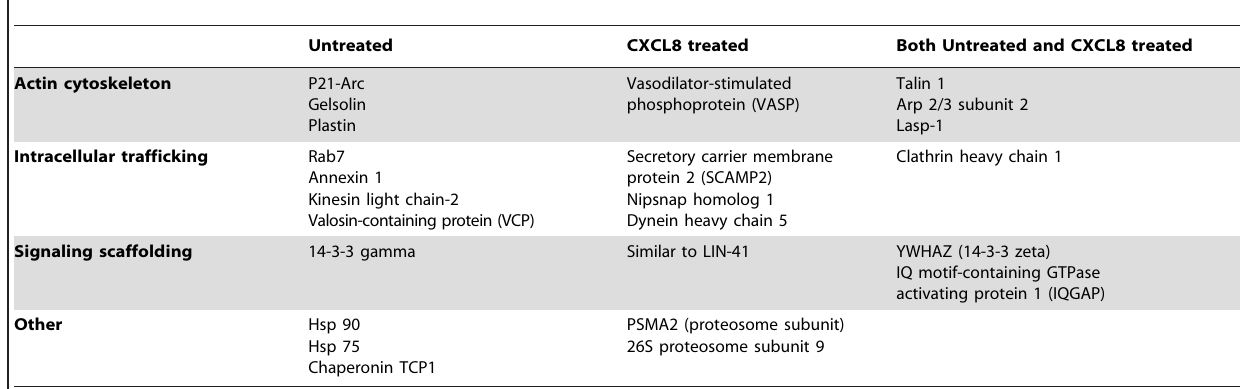
Table 2. List of identified proteins from untreated and CXCL8 stimulated cells in LC/MS/MS